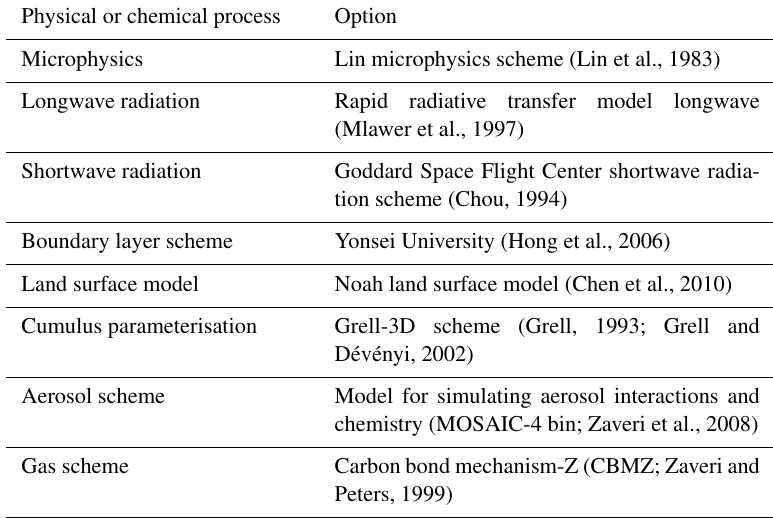
Figure 1. (a) Maps of the WRF modelling domain and (b) central China. The colour bars represent the terrain altitude. The black rectangles in (a) are North China Plain (NCP), northeastern China (NEC), Energy Golden Triangle (EGT), Xinjiang (XJ), Sichuan Basin (SB), Yangtze River Delta (YRD), and Pearl River Delta (PRD). The red rectangle in (a) represents central China (CC). (b) The details of CC. Black circle with dots in (b) represent the locations of large cities. The red characters in (b) are the name of provinces, and the black characters are the name of capital cities. Wuhan and Changsha are the capitals of Hubei and Hunan provinces. Inset in (a) : South China Sea. Units: m. Table 1. WRF–Chem model